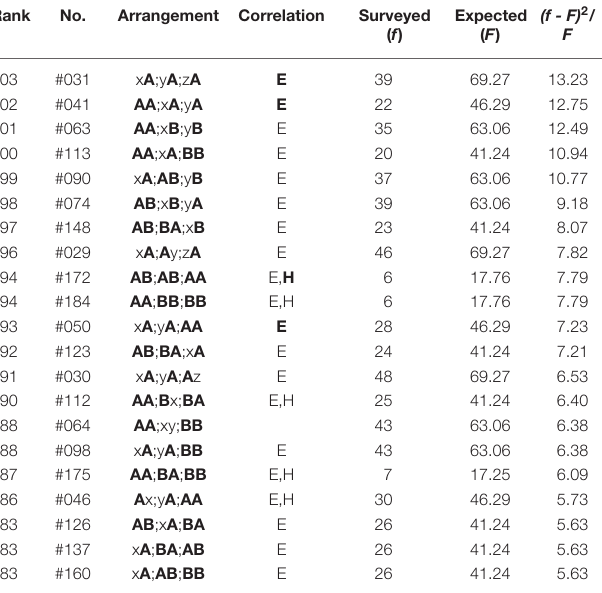
TABLE 3 | The top-twenty arrangements in The Complete Haiku Works of Shuoshi Mizuhara , wherein there are 9362 poems included. Rank No. Arrangement Correlation Surveyed